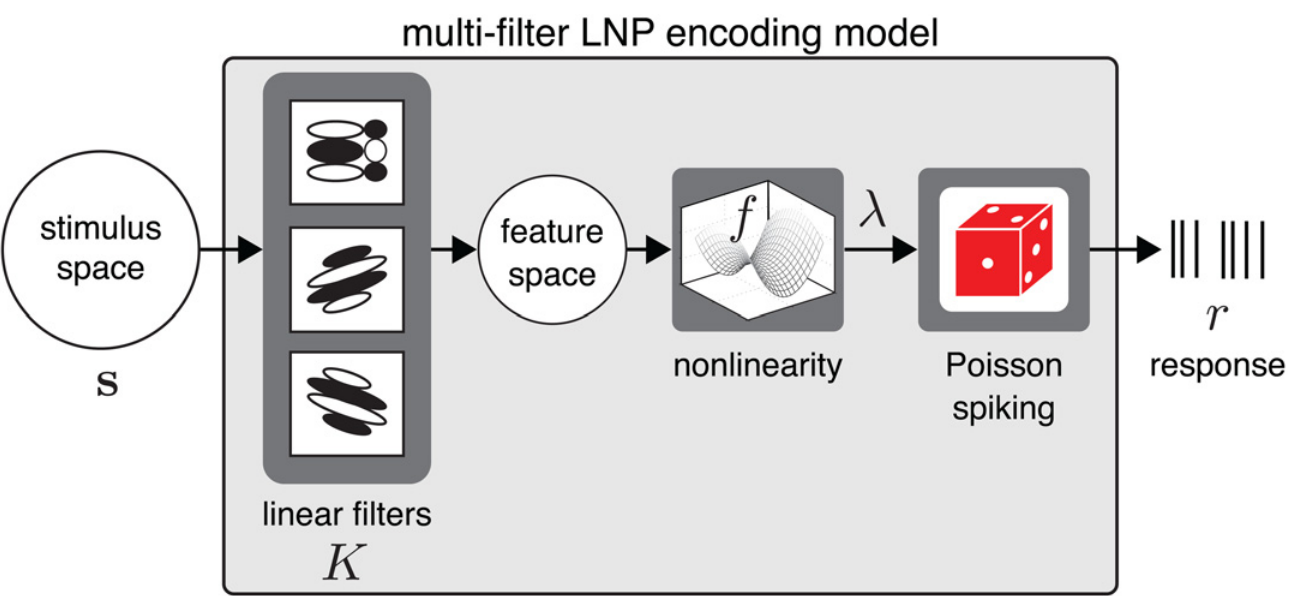
Fig 1. The linear-nonlinear-Poisson (LNP) encoding model formalizes the neural encoding process in terms of a cascade of three stages. First, the high-dimensional stimulus s projects onto bank of filters contained in the columns of a matrix K , resulting in a point in a low-dimensional neural feature space K > s . Second, an instantaneous nonlinear function f maps the filtered stimulus to an instantaneous spike rate λ . Third, spikes r are generated according to an inhomogeneous Poisson process.